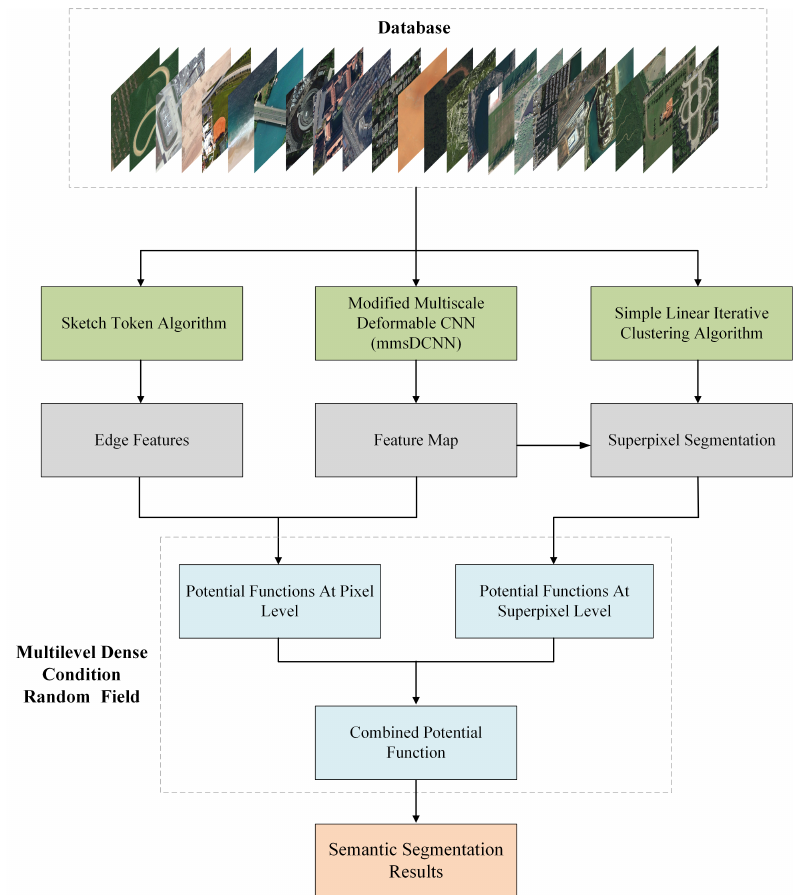
Figure 2. The figure shows the basic framework of the proposed